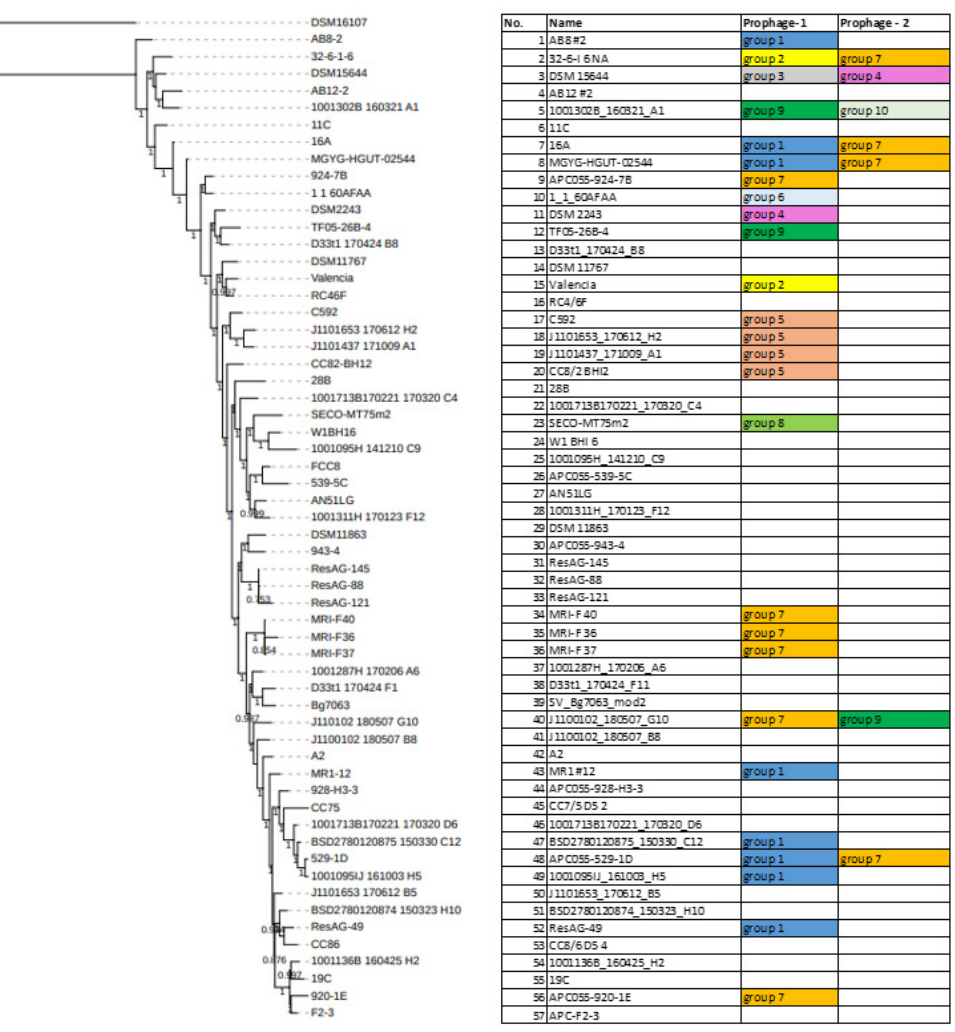
Figure 9. Phylogram constructed from concatenated core genes as predicted by ROARY with protein alignment using PRANK and tree constructed by FASTTree; bootstrap branch support indicated with values from 0 to 1. The table indicates the presence or absence of representatives of a particular prophage clade integrated into the genome of the bacterial isolate described.